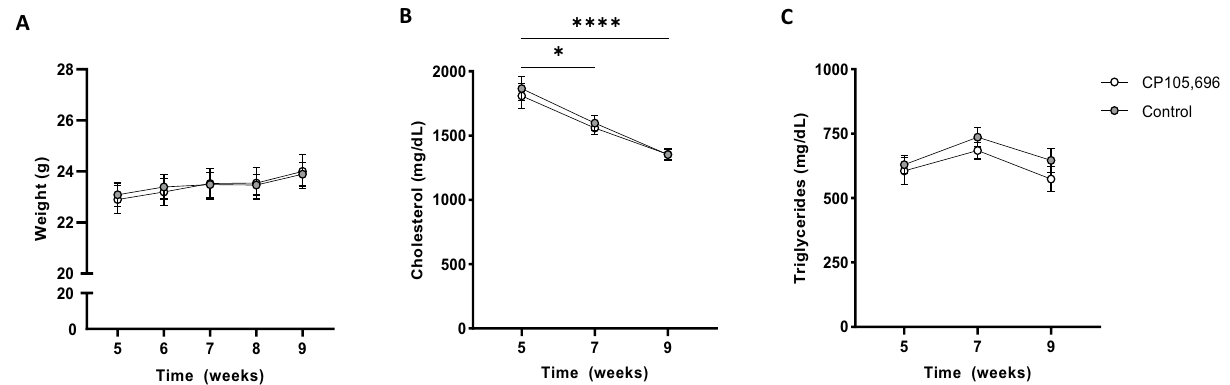
Figure 2. Body weight and plasma lipid levels upon CP105,696 treatment in LDLr −/− mice. ( A ) Body weight of mice was measured weekly during treatment and was not affected by CP105,696 treatment. ( B ) Plasma cholesterol and ( C ) triglyceride concentrations were obtained at t = 5, t = 7 and t = 9. n = 15 per group. Data represent mean ± SEM. * p < 0.05; **** p <